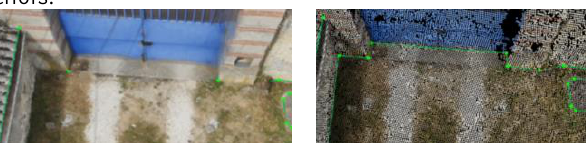
Figure 9: Illustration of potential manual pointing errors.